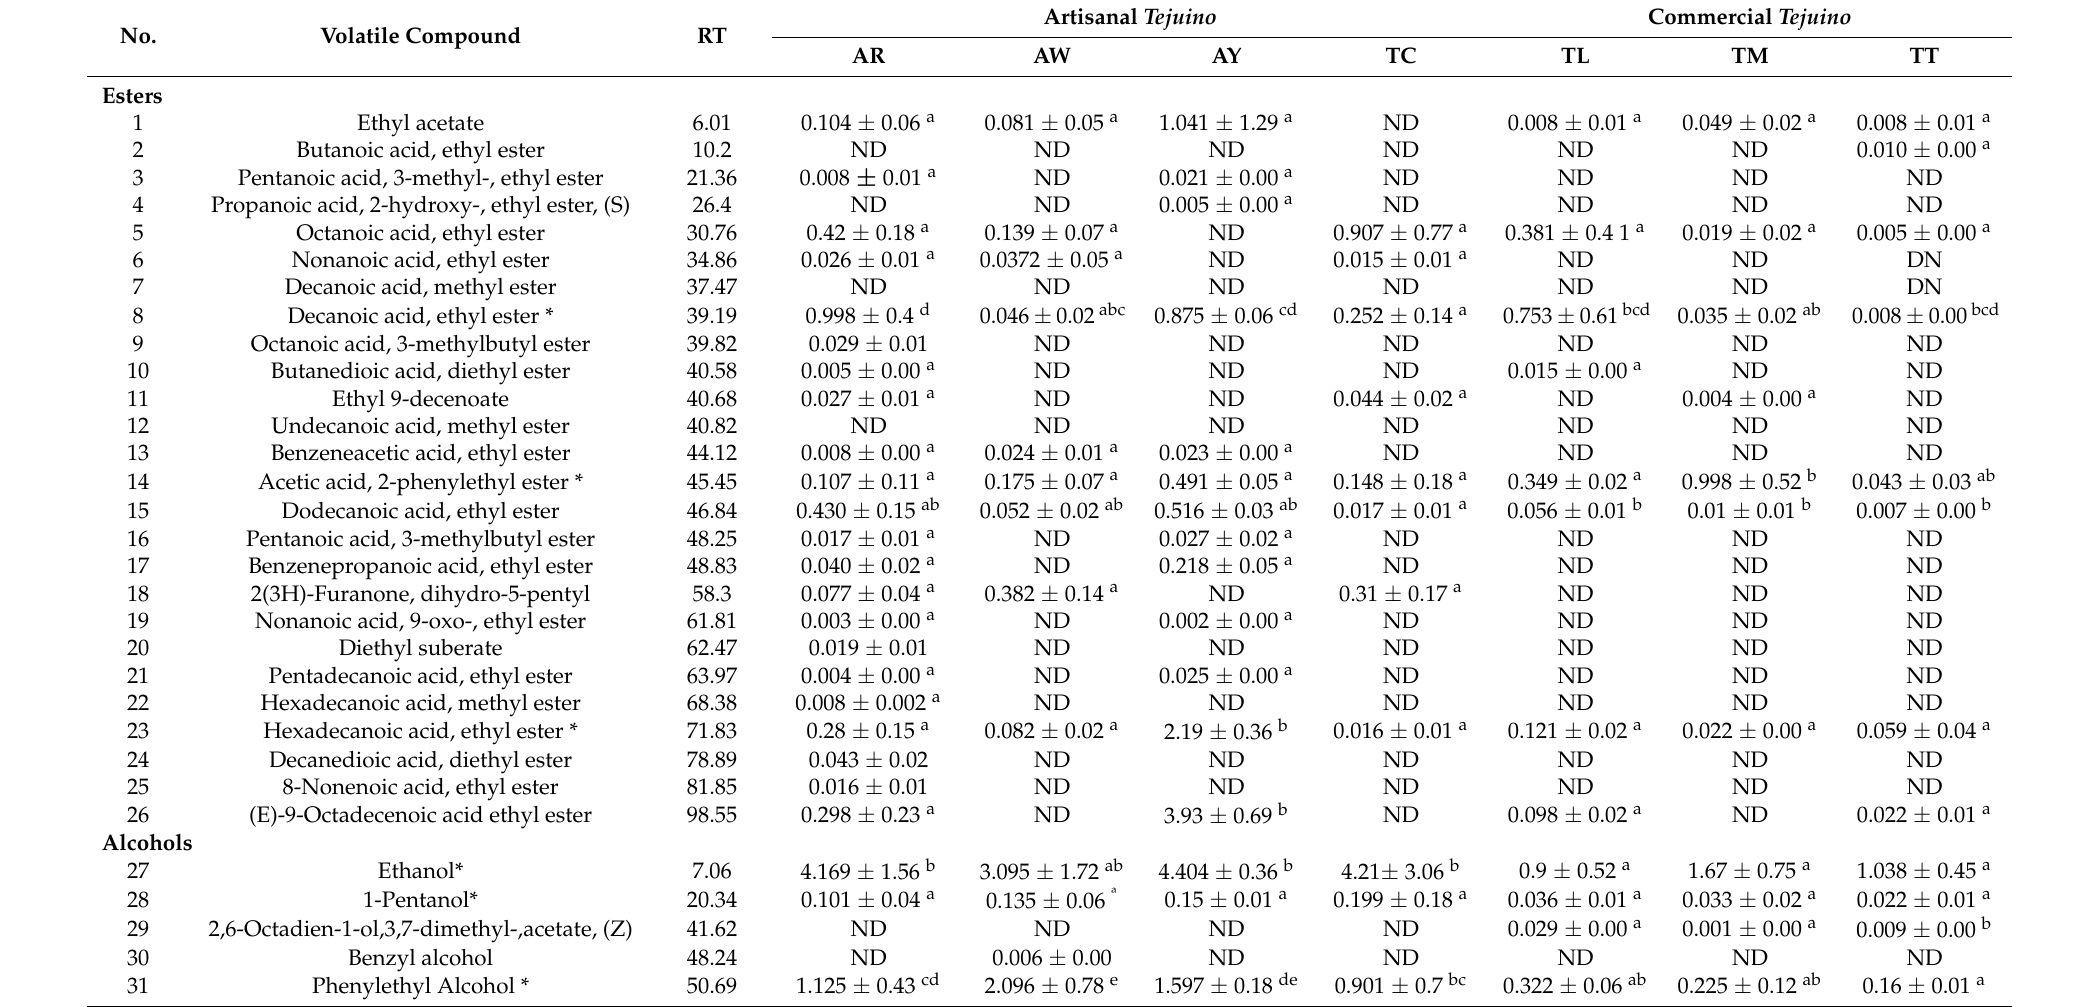
Table 4. Volatile compounds identified in Tejuino beverage by headspace solid-phase microextraction and GC-MS (ppm).